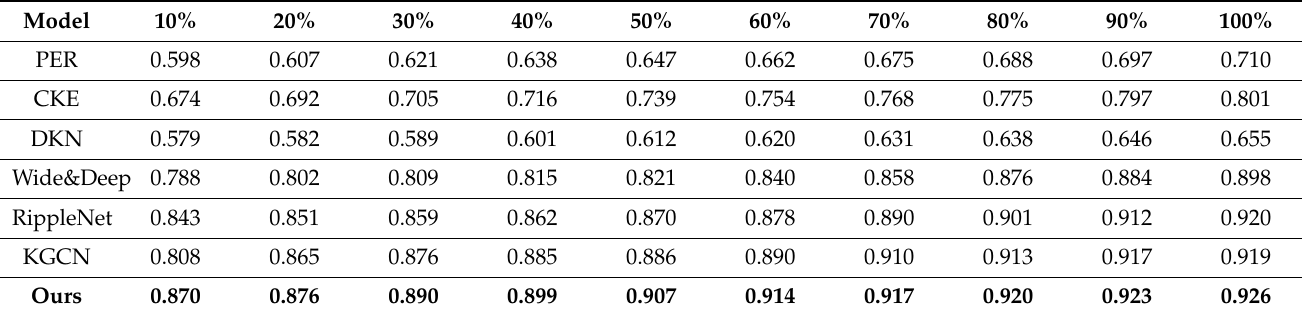
Table 4. Results of partitioning training set into different